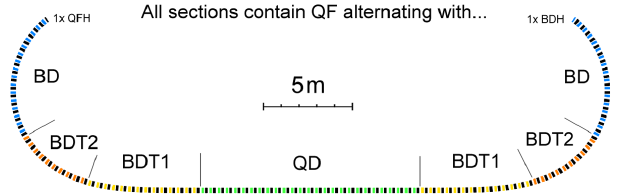
FIG. 2. The fixed-field return loop for the CBETA